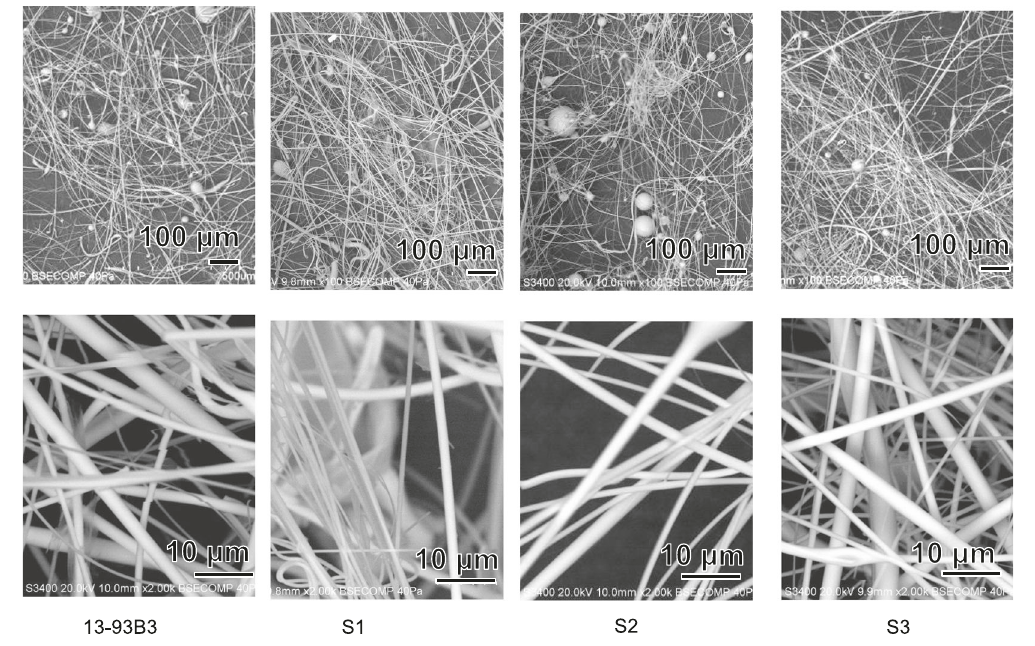
Fig. 3 SEM pictures of as-prepared glass fi